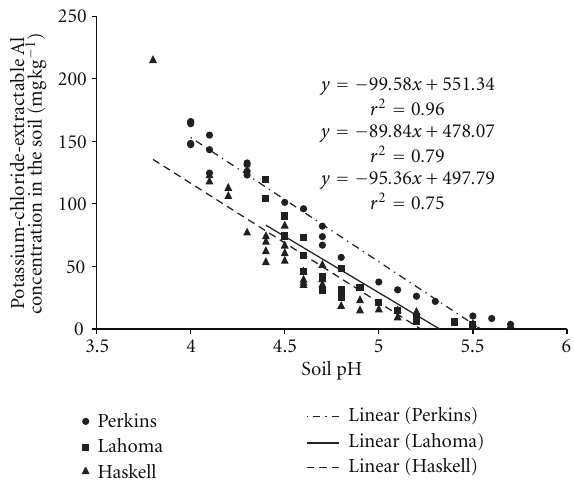
Figure 3: Relationship between potassium-chloride-extractable Al concentration in the soil and soil pH from a 15cm composite soil sample for each treatment at Perkins, Lahoma, and Haskell, Okla- homa (2010).